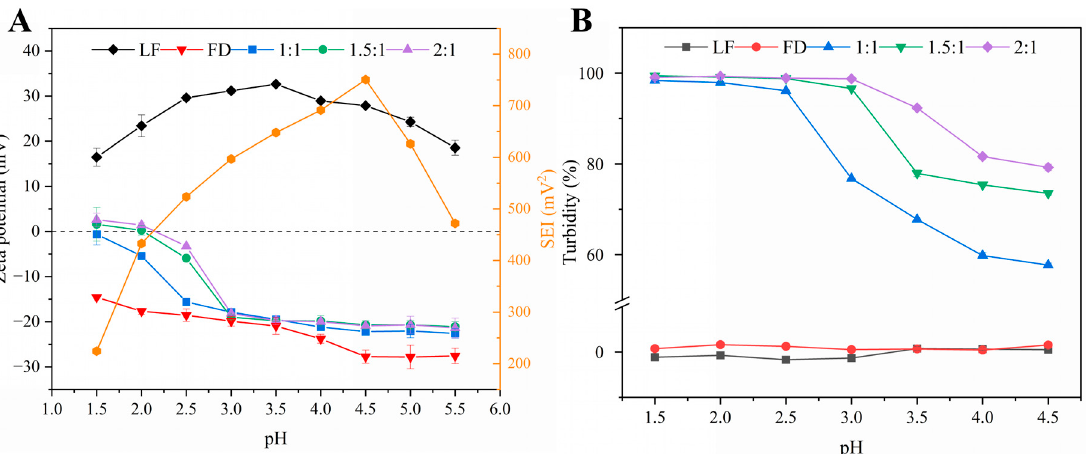
Figure 1. The zeta potential, SEI ( A ), and turbidity ( B ) of LF, FD, and the LF–FD complexes (1:1, 1.5:1 and 2:1) as a function of pH. and 2:1) as a function of